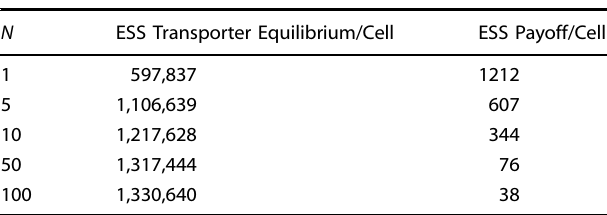
Table 3. GLUT1 inhibitor ESS transporter equilibria and